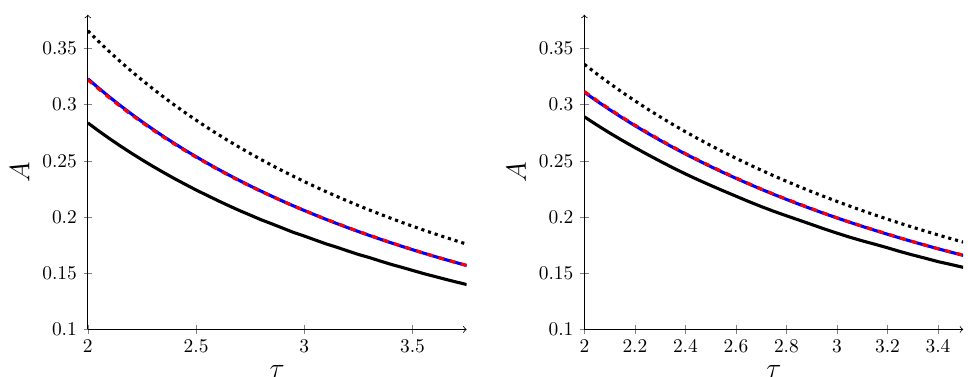
Figure 9 . The amplitude A (or maximum of the energy density rapidity distribution) for asymmet- ric collisions with ( w ; w (cid:0) ) = (0 : 075 ; 0 : 35) (left) and ( w ; w (cid:0) ) = (0 : 1 ; 0 : 25) (right), shown as the + + (middle) blue line. In each plot, the upper (dotted) line and lower (solid) line show the amplitude for the corresponding symmetric collision with wider or narrower width, respectively. In each plot, the red dashed line, overlaying the middle blue curve, shows the geometric mean of the respective symmetric collision results.